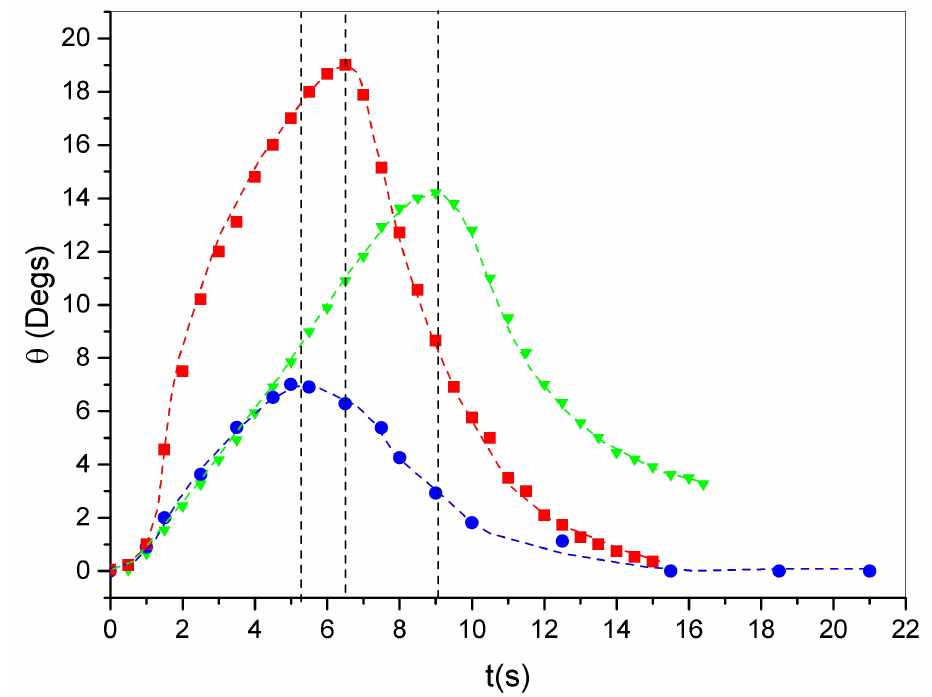
Figure 5. Angular displacement (Degs) as a function of time (s) for three different wavelengths, λ = 405 (blue filled circles), 532 (green filled triangles), and 650 (red filled squares) nm. The dashed lines represents the points where the laser lights are switched off.